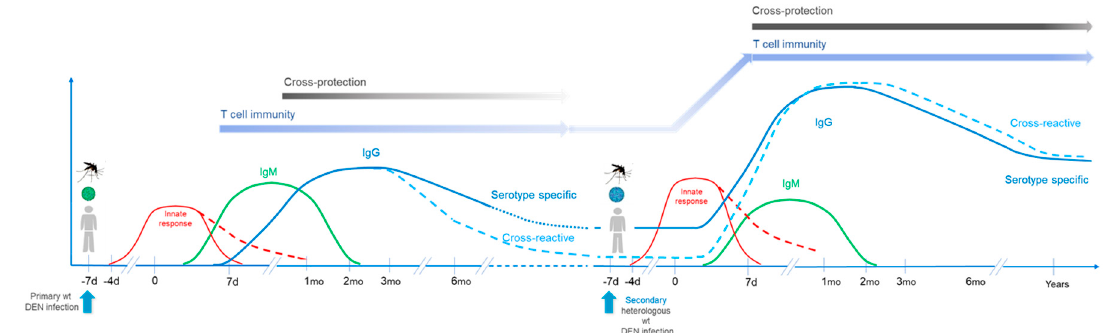
Figure 2. Upon secondary heterologous wild type dengue infection, innate responses develop early as after primary infection, but may present higher levels and a more inflammatory profile. Dengue specific IgM responses still develop, possibly at lower levels than after primary infection. IgG responses are triggered/boosted earlier than upon primary infection and reach higher levels. Of importance, cross-reactive responses raise to higher levels too, also presenting some higher affinity and different specificity. CD4+ and CD8+ T cell responses are also triggered/boosted, and as for IgG responses present a broader specificity. These responses then support longer and more efficient cross-protection. d: day; mo: month; y: year; wt: wild type.